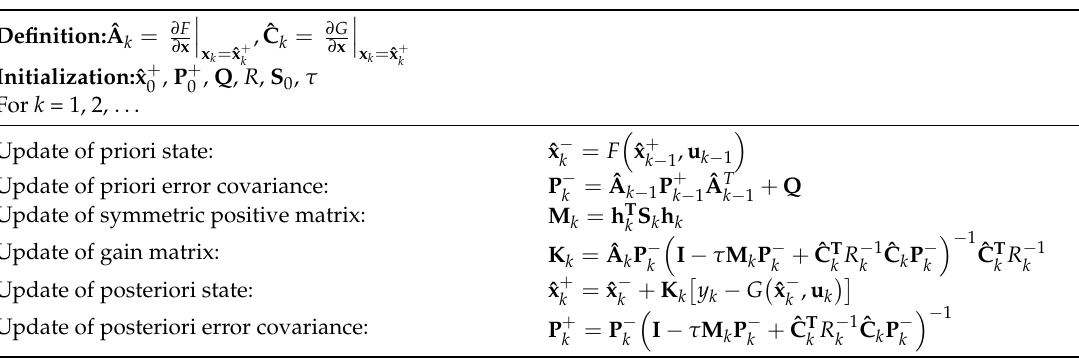
Table 1. Algorithmic procedures of the H-Infinity Filter